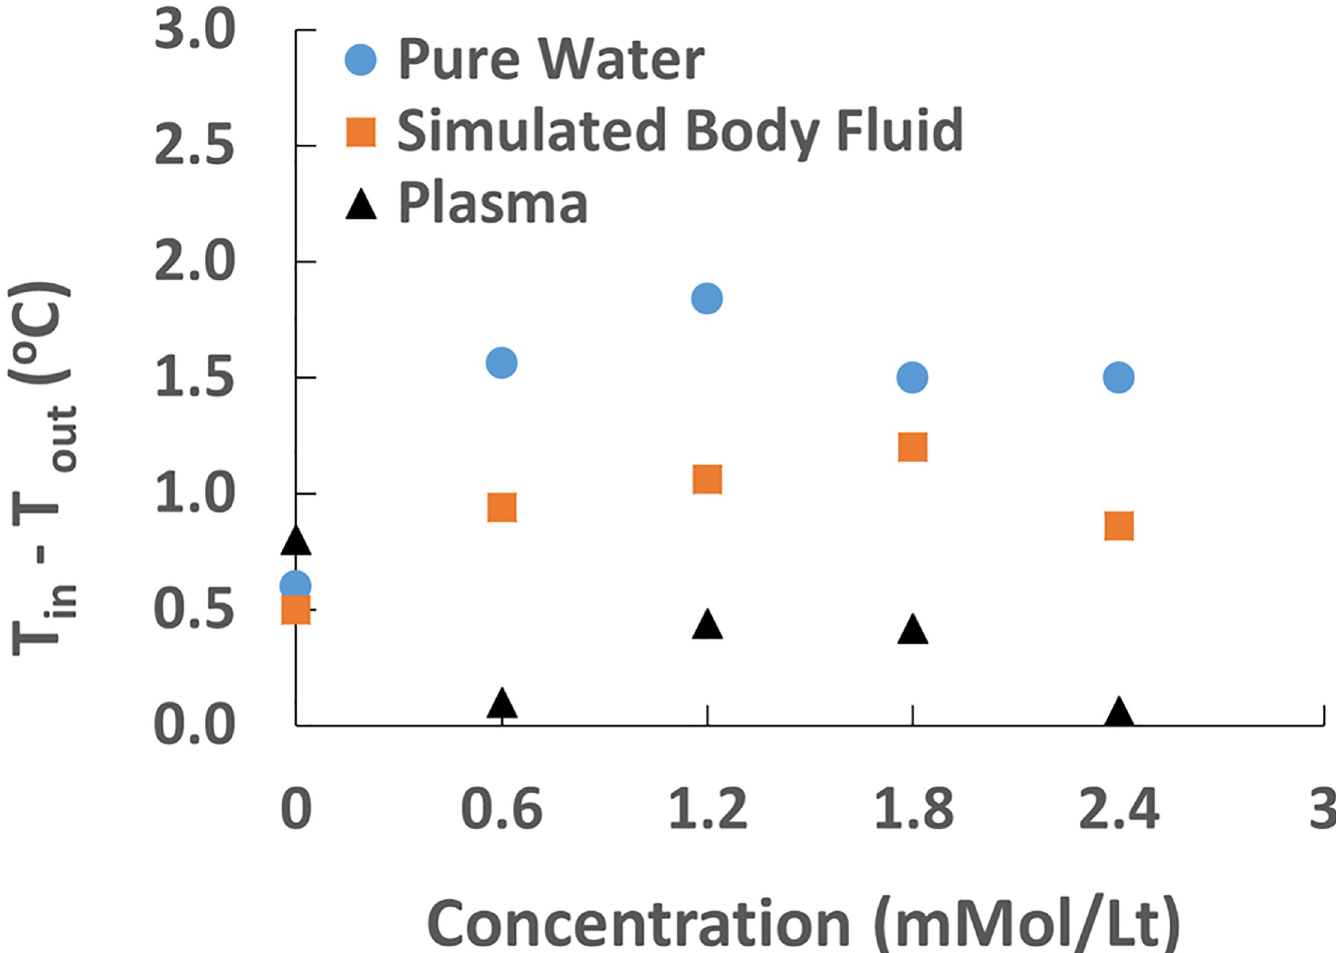
Fig 5. Scatter plots showing correlation between temperature difference ( Δ T overall ) and concentration in different